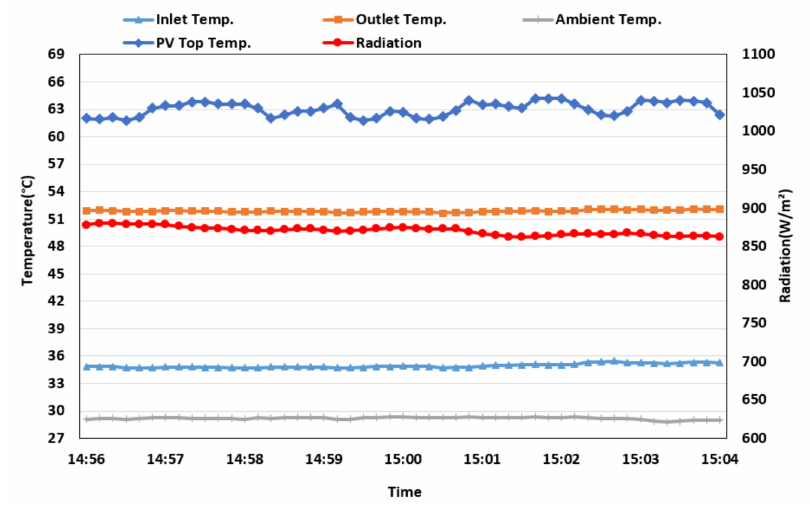
Figure 5. Temperature characteristics of air-type PVT